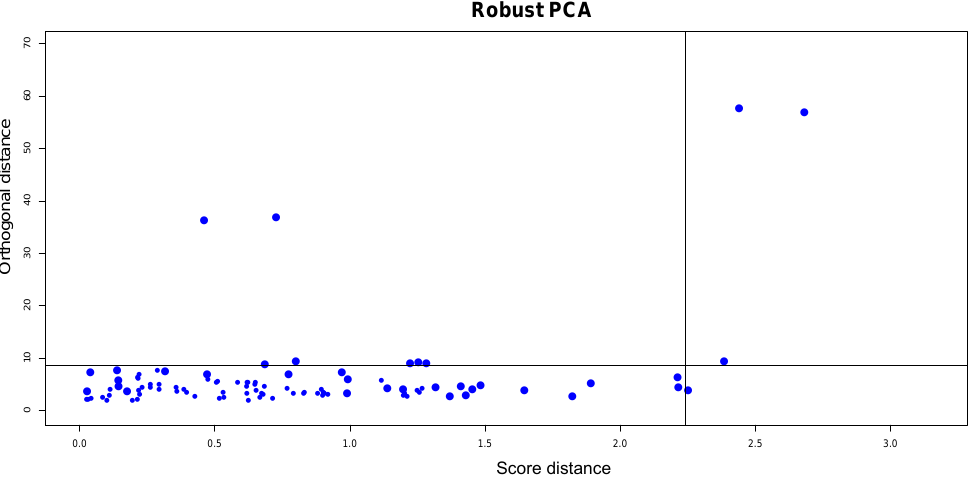
Figure 2. Outlier map created using Robust Principal Component Analysis (ROBPCA) (Rospca package available in the R environment) on a simulated dataset. Based on the previous classification, the first quadrant (top-right) of the DD-plot (Distance-Distance plot) contains the BLP s, the second quadrant (top-left) encloses the OO s, the third quadrant (bottom-left) has the RO s, and, finally, the fourth quadrant (bottom-right) contains the GLP